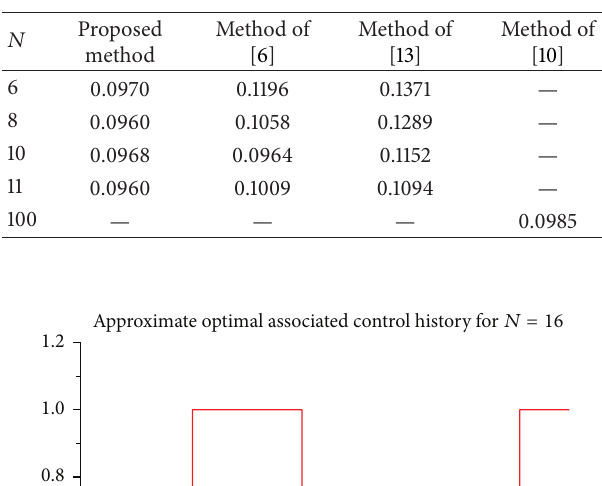
Table 2: Comparisons of the methods in evaluating the objective function 𝐽 ∗ .